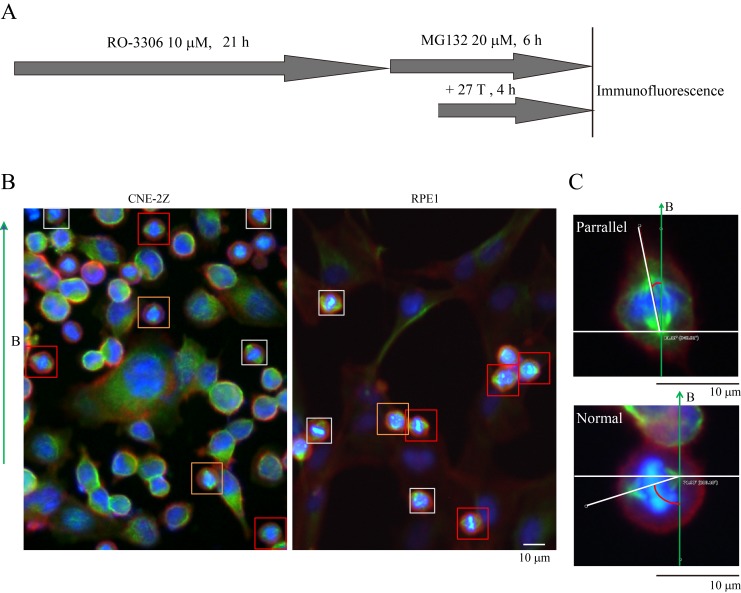
Synchronization procedure to enrich mitotic cells and spindle orientation measurement.(A) Schematic illustration of the experimental procedure. (B) Representative immunofluorescence images of CNE-2Z and RPE1 cells show that 27 T SMF changes spindle orientation. Spindles with different orientations were labeled by boxes with different colors. Orange indicates parallel to the field direction; Red indicates normal to the field directions; Gray indicates others that are not parallel or vertical to the field direction. Scale bar: 10 μm. (C) The angle between spindles and the magnetic field direction was measured. The angles were measured by drawing a line between the two spindle poles and a line for the field direction.